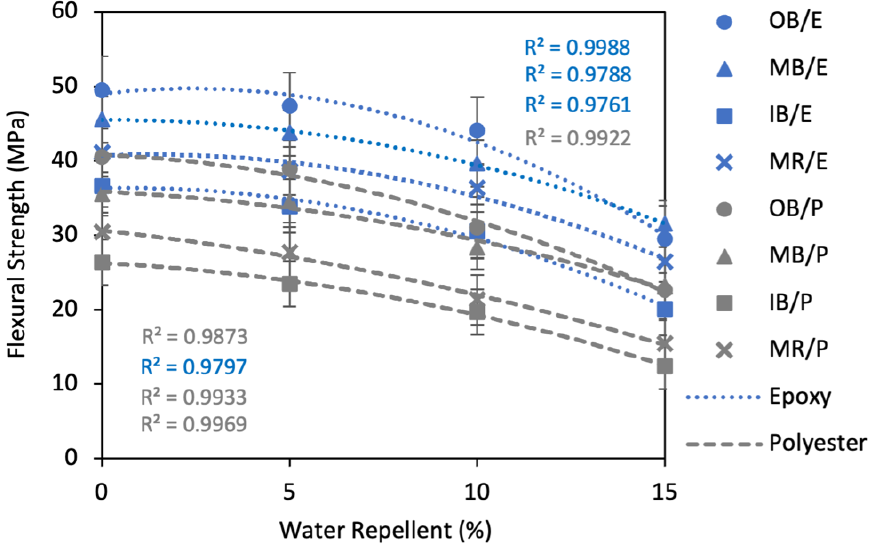
Figure 13. Effect of water repellent on the flexural strength of the composites.